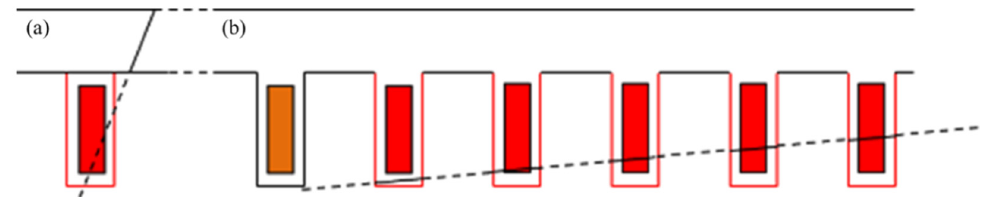
Figure 5. The example DFN realization using the DFN recipe and the repository. ( a ) The fractures that intersect the repository are divided into connected (in light blue color) and isolated fractures (in orange color). It is also noted that colors are influenced by light and shade; ( b ) The close view of the MT (in red color), DT (in green color), the connected fractures (in light blue color), and iso- lated fractures (in orange color).